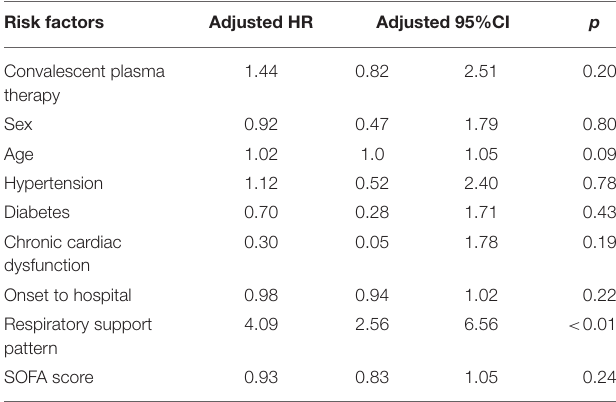
TABLE 3 | Extended Cox model to explore effects of convalescent plasma therapy with 60-day mortality in severe and life-threatening coronavirus disease 2019 (COVID-19).